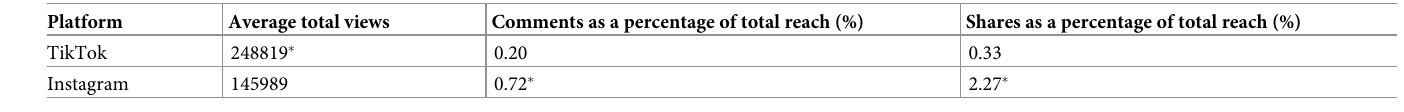
� indicates value is significantly higher than the other values presented in the same